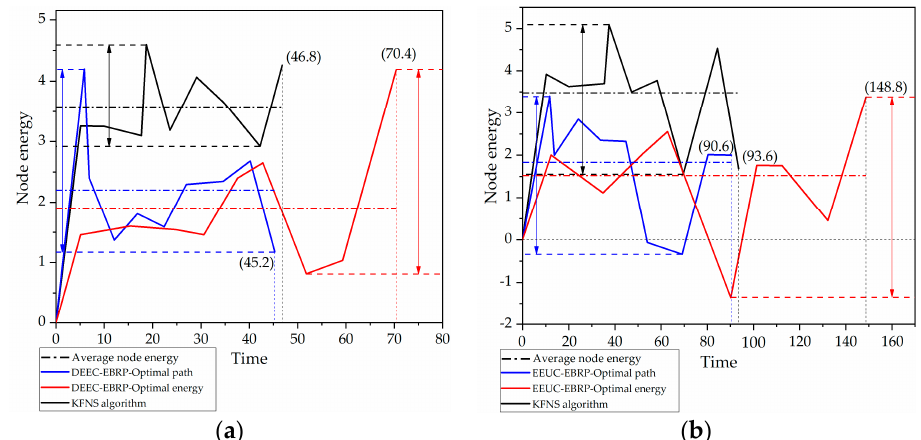
Figure 12. Comparison of node recovery results. ( a ) Single-hop coverage. ( b ) Multi-hop coverage.